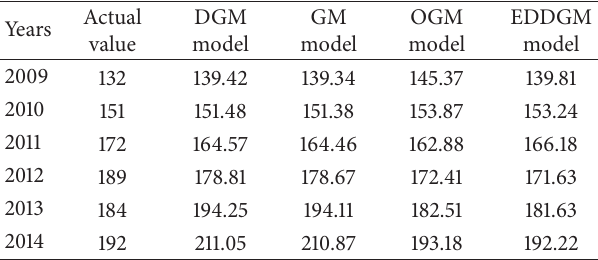
Table 2: Comparison between predicted and actual value of four models.